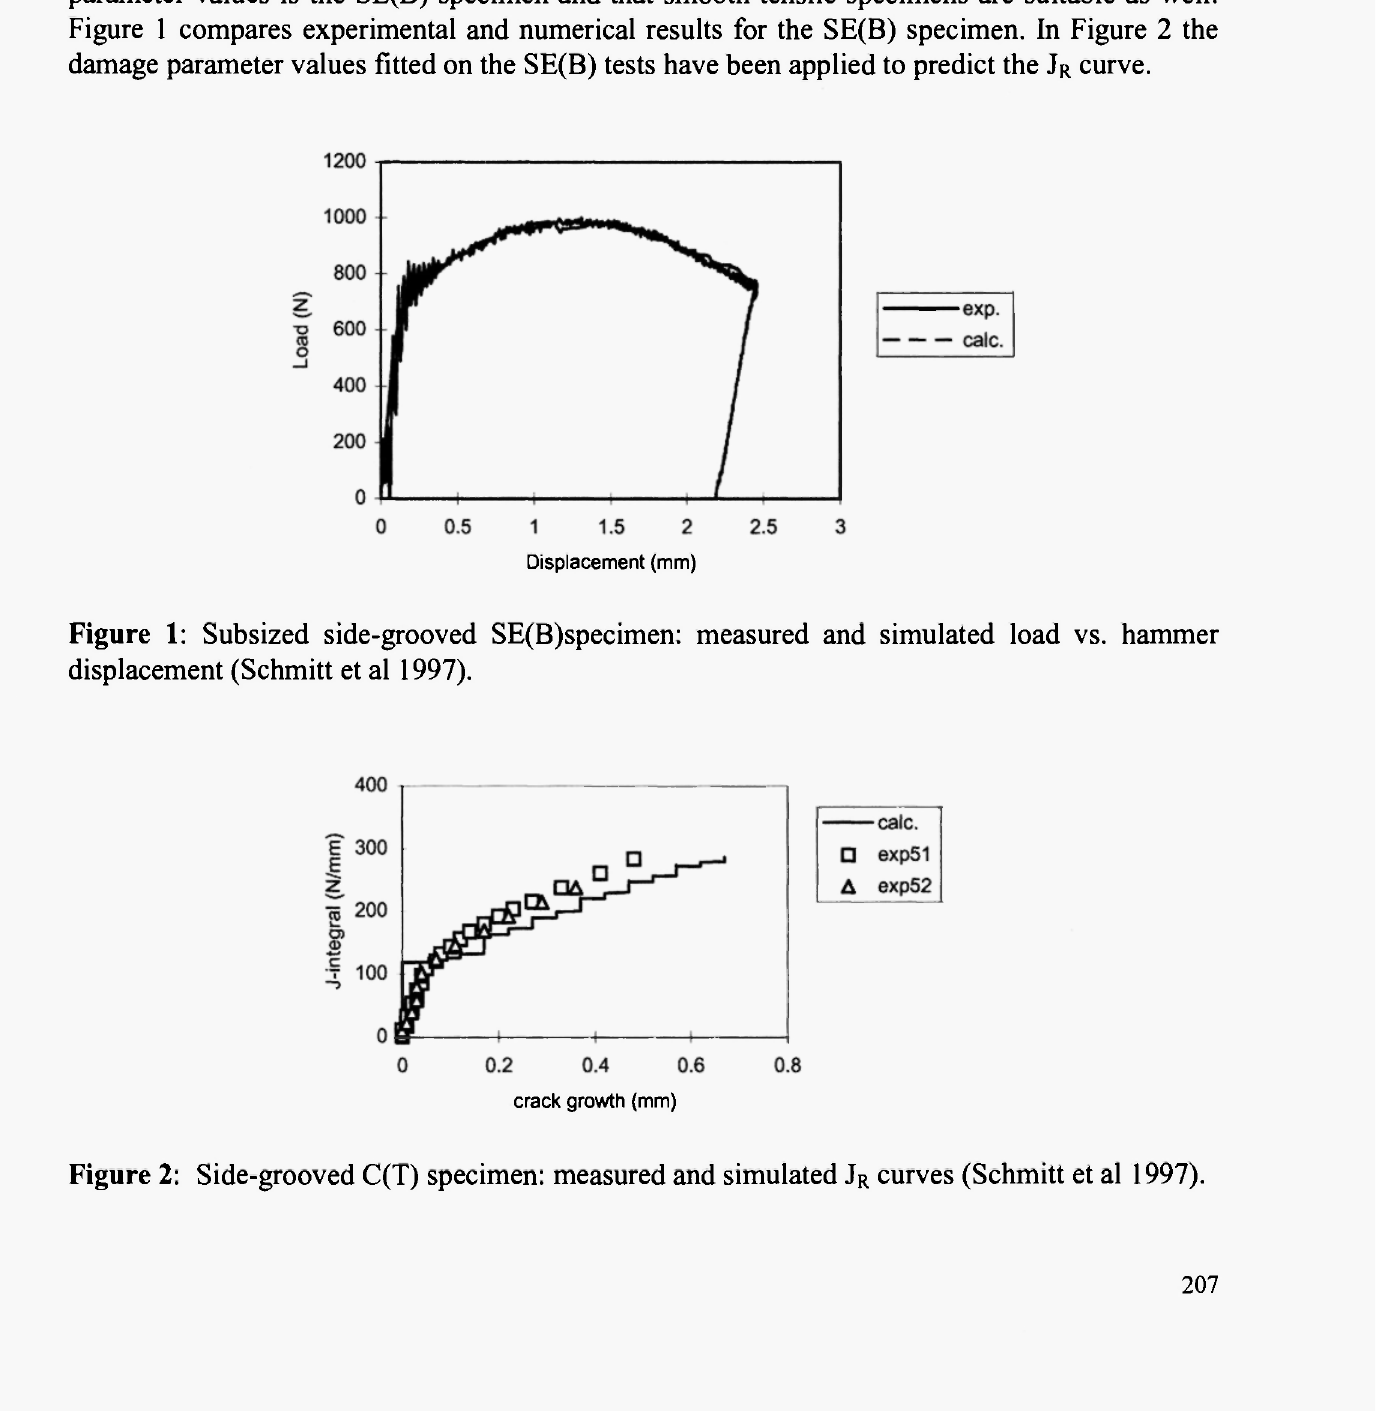
Figure 2: Side-grooved C(T) specimen: measured and simulated J